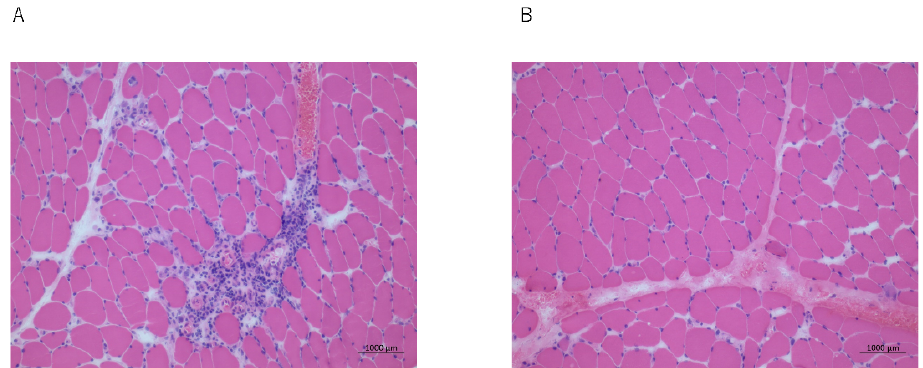
Figure 1. Pathological findings. Photomicrographs of the muscle biopsy specimens. ( A ) Features of inflammatory myopathy, such as focal perifascicular atrophy and perivascular lymphocytic infiltration of the perimysium and endomysium, are seen (patient 1); ( B ) Features of inflammatory myopathy are seen (patient 2). Scale bar = 150 µ m ( A , B ).